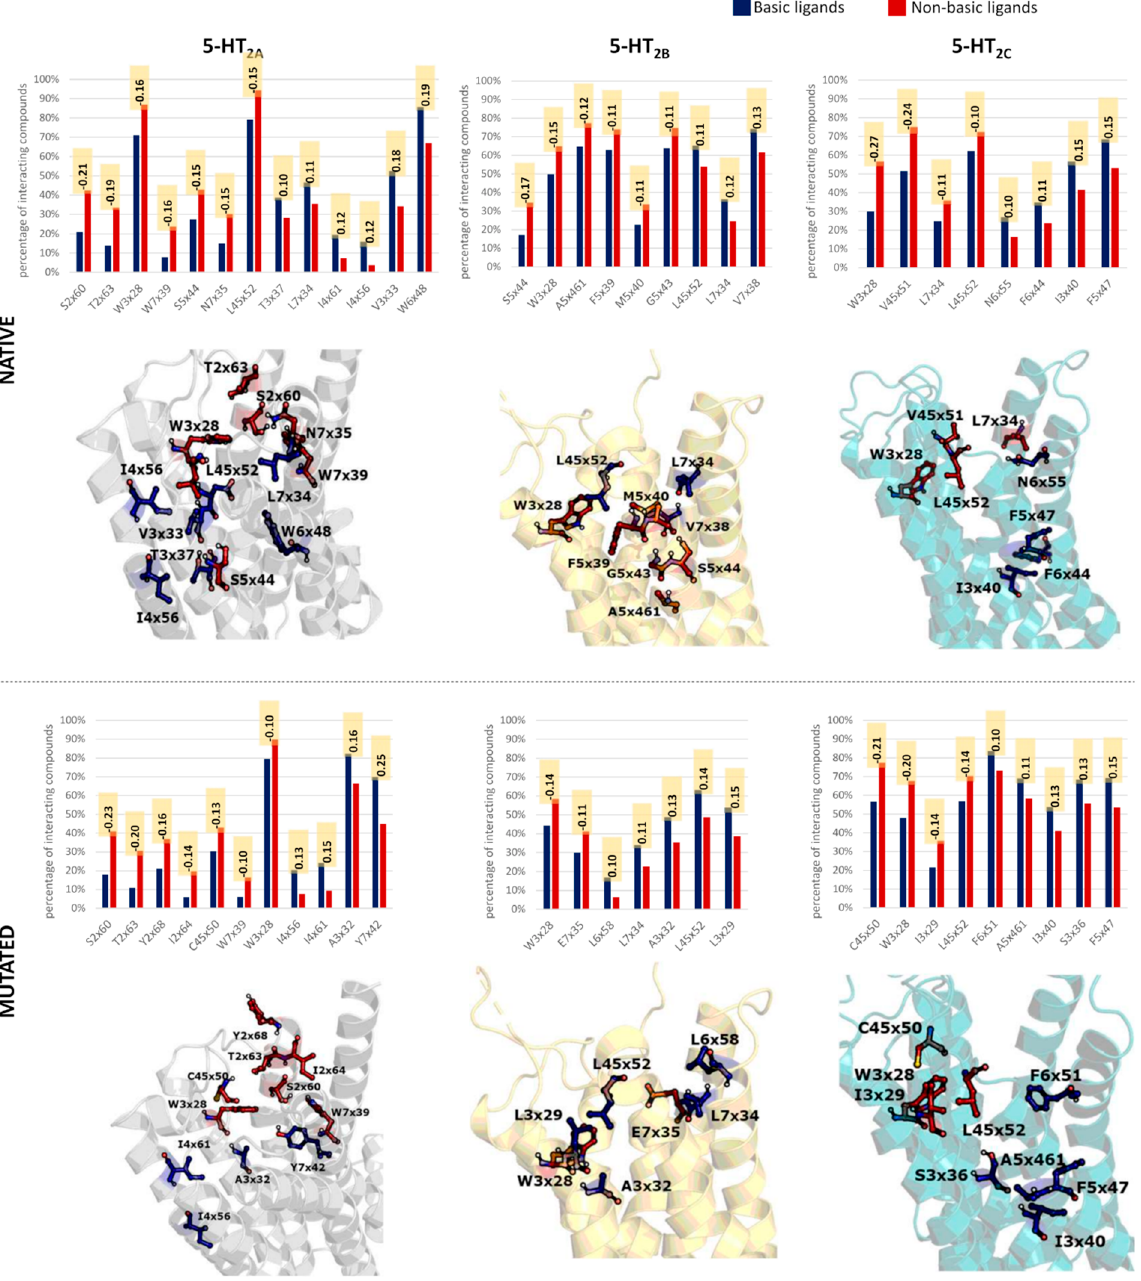
Figure 5. Comparison of interaction frequencies with basic and non-basic compounds of selected amino acids (positions with the highest differences in the interaction frequencies are presented), together with their indication in the respective crystal structures—5-HT 2A : 6A94, 5-HT 2B : 4IB4, 5-HT 2C : 6BQH. Differences in the interaction frequencies are depicted in orange boxes.